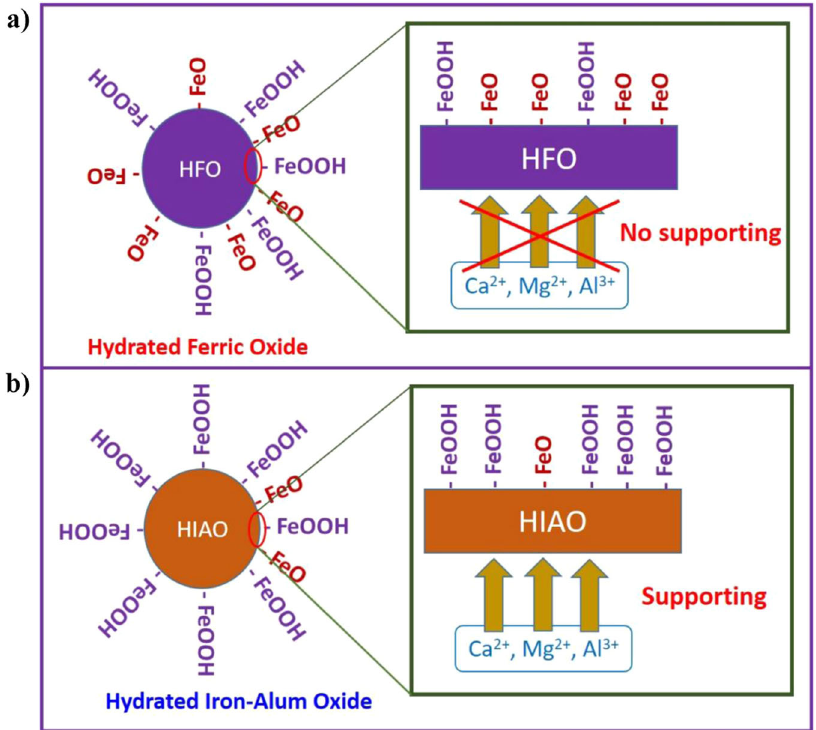
Fig. 6 Mechanism for the enhanced formation of FeOOH on the surface of HIAO. a The surface of the material without the presence of ions: Ca 2 + , Mg 2 + , and Al 3 + . b The surface of the material has the presence of ions: Ca 2 + , Mg 2 + , and Al 3 + .